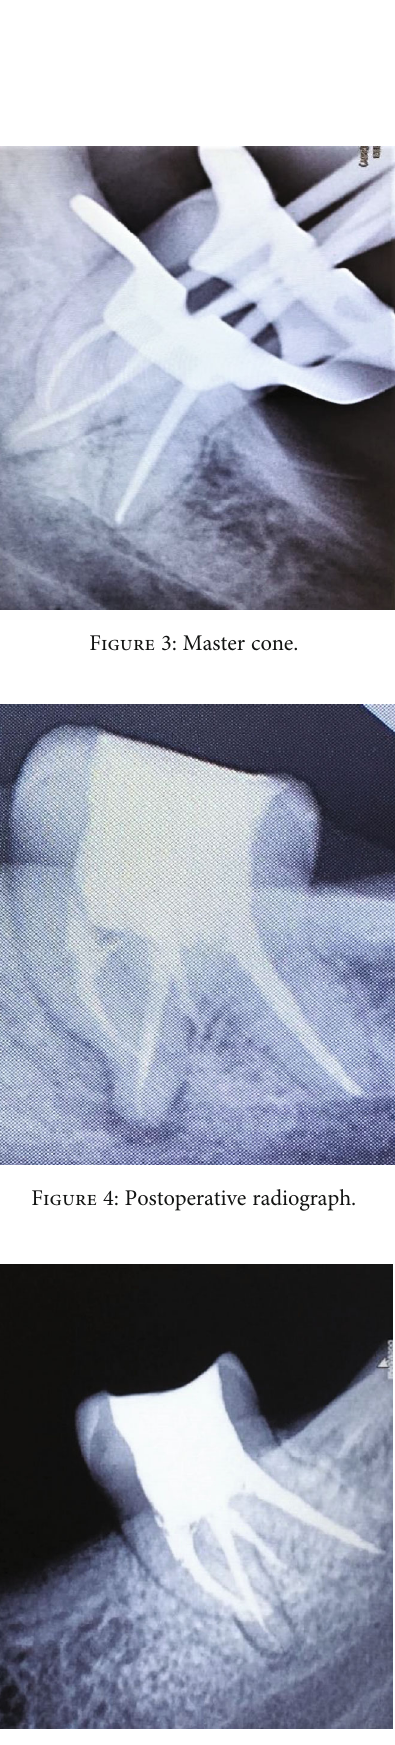
Figure 5: 1-year